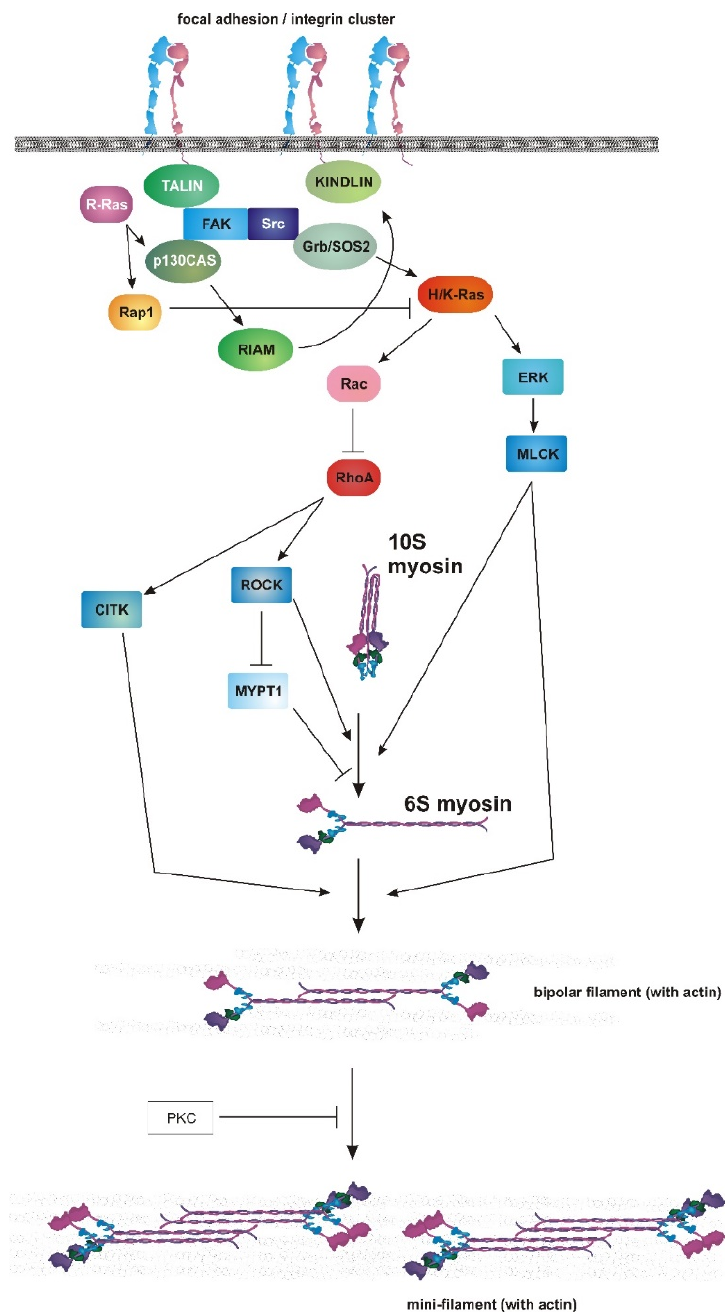
Figure 3. Control of myosin II activation by upstream signaling. Figure depicts diverse signaling pathways coming from and to the focal adhesions, including various Ras isoforms, and possible routes by which Ras, Rac and RhoA drive the different steps of myosin II activation, including conformational deployment (10S to 6S); the formation of the unstable species 6S, which forms bipolar filaments immediately; and the role of PKC in mini-filament stability. GTPases are shown in red-hued, round-edged boxes; adaptors in green-hued ellipses; and catalytic proteins in blue-hued boxes.